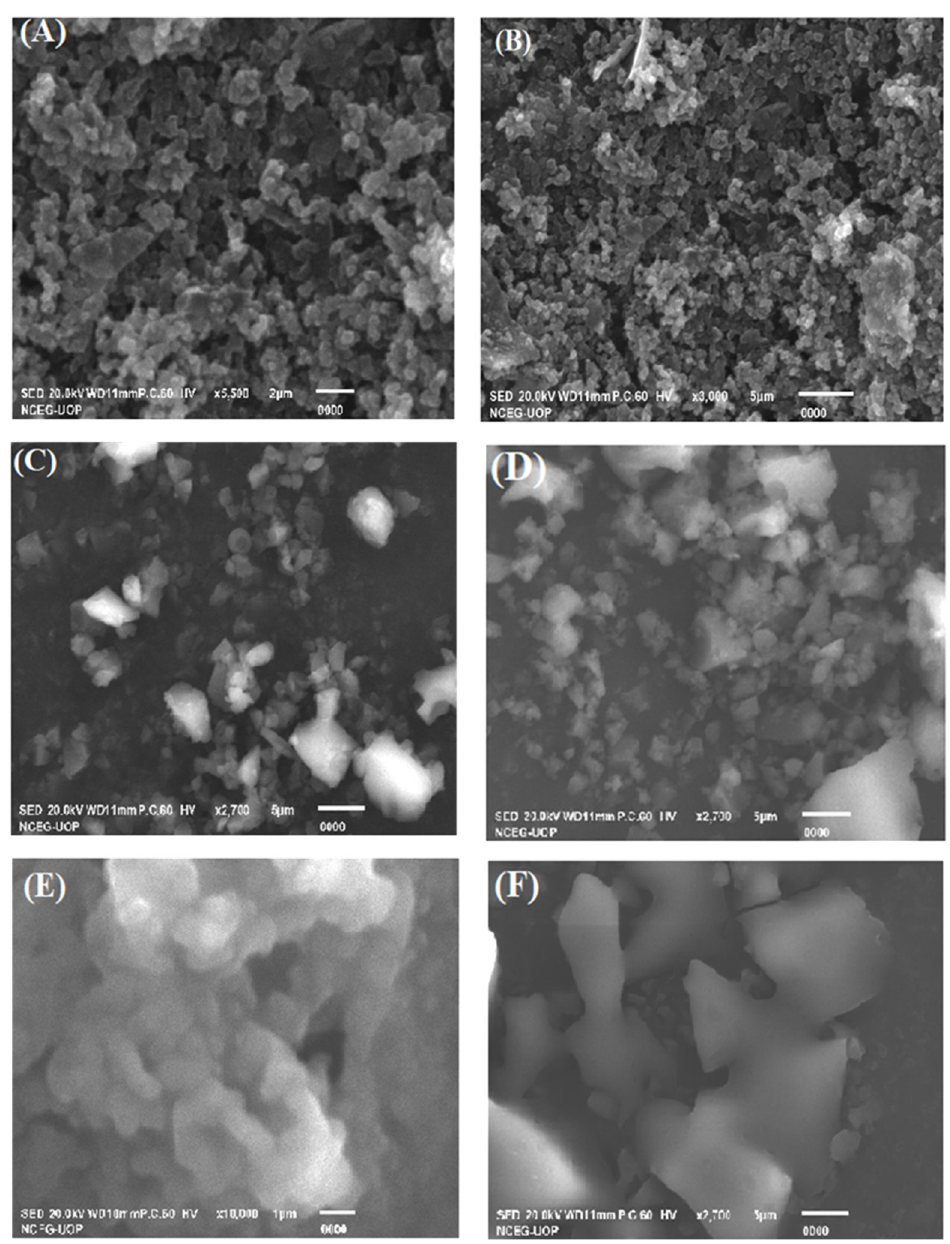
Figure 4. SEM images of ( A ) PPy, ( B ) PPy/GA 1, ( C ) PPy/GA 2, ( D ) PPy/GA 3, ( E ) PPy/GA 4, and ( F ) PPy/GA 5.